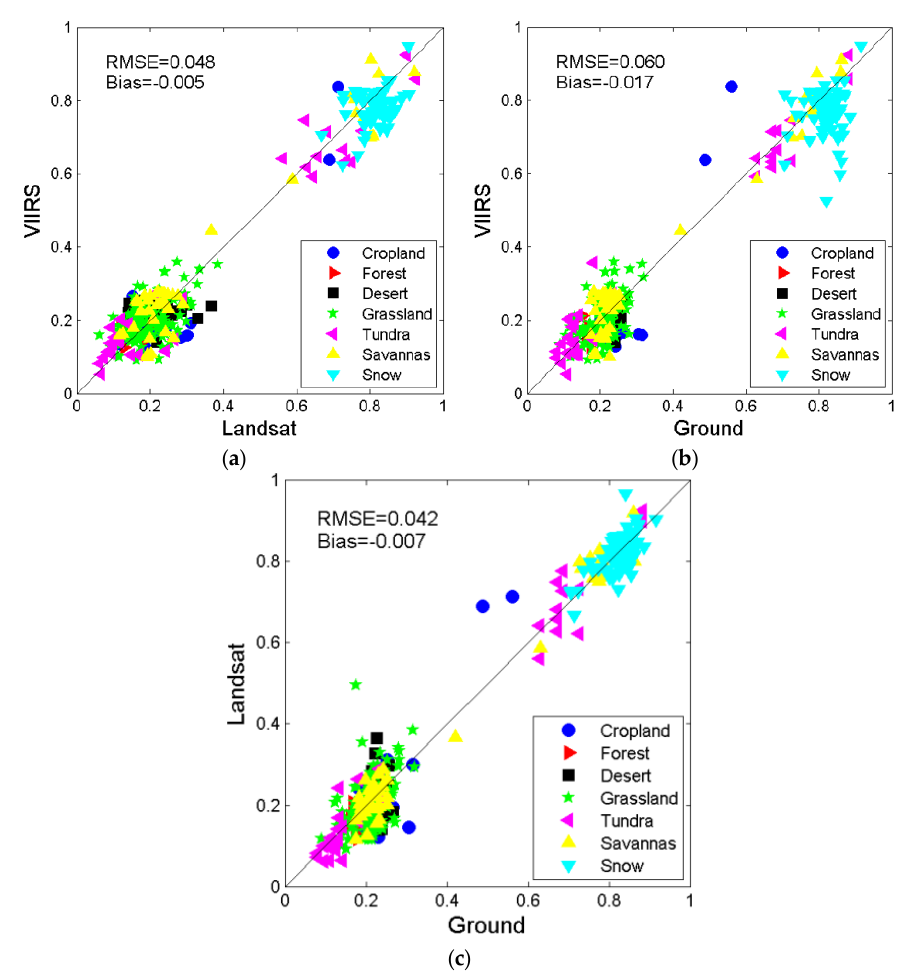
Figure 7. Inter-comparison results between VIIRS LSA and Landsat retrieved albedo over all sites listed in Table 1. ( a ) VIIRS validated against Landsat; ( b ) VIIRS validated against ground truth; ( c ) Landsat validated against ground truth.